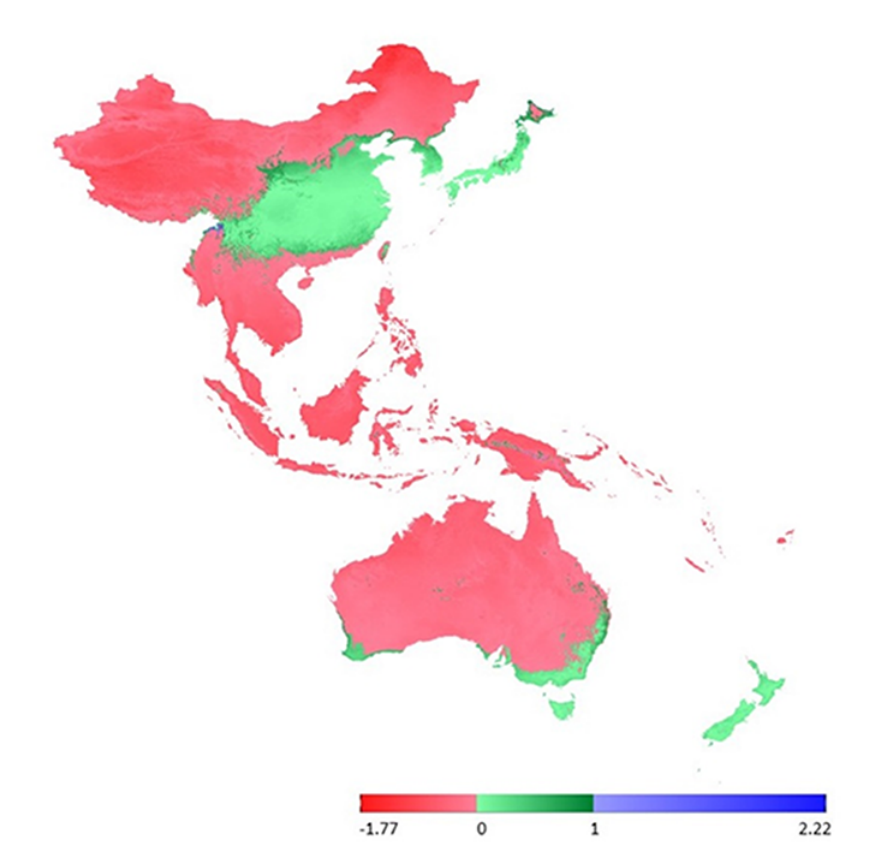
Figure 5 ExDet map showing the quantification of extrapolated projection areas for Lewinskya graphiomitria based on the second set of variables (BIO2, BIO6, and BIO13). No extrapolation (green), type 1 novelty (red), and type 2 novelty